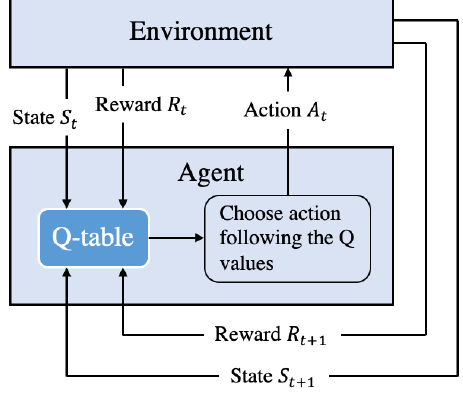
Figure 2. Q-learning